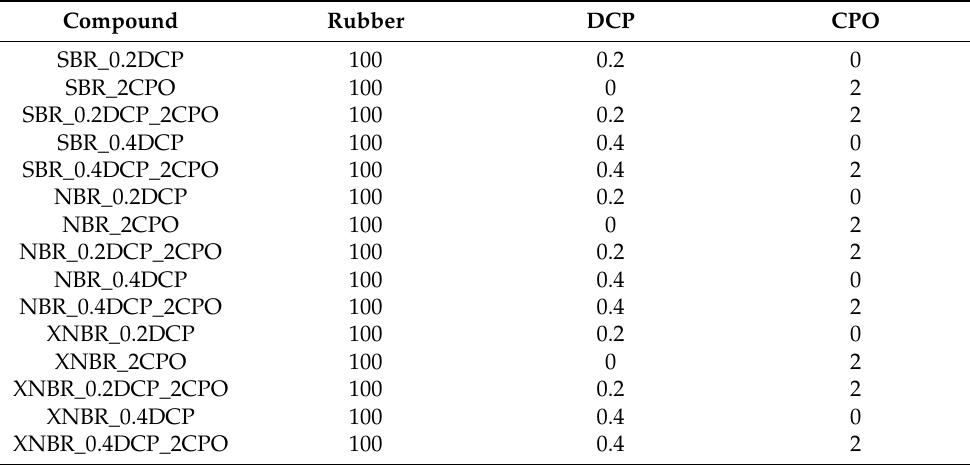
Table 1. Composition of the rubber compounds studied